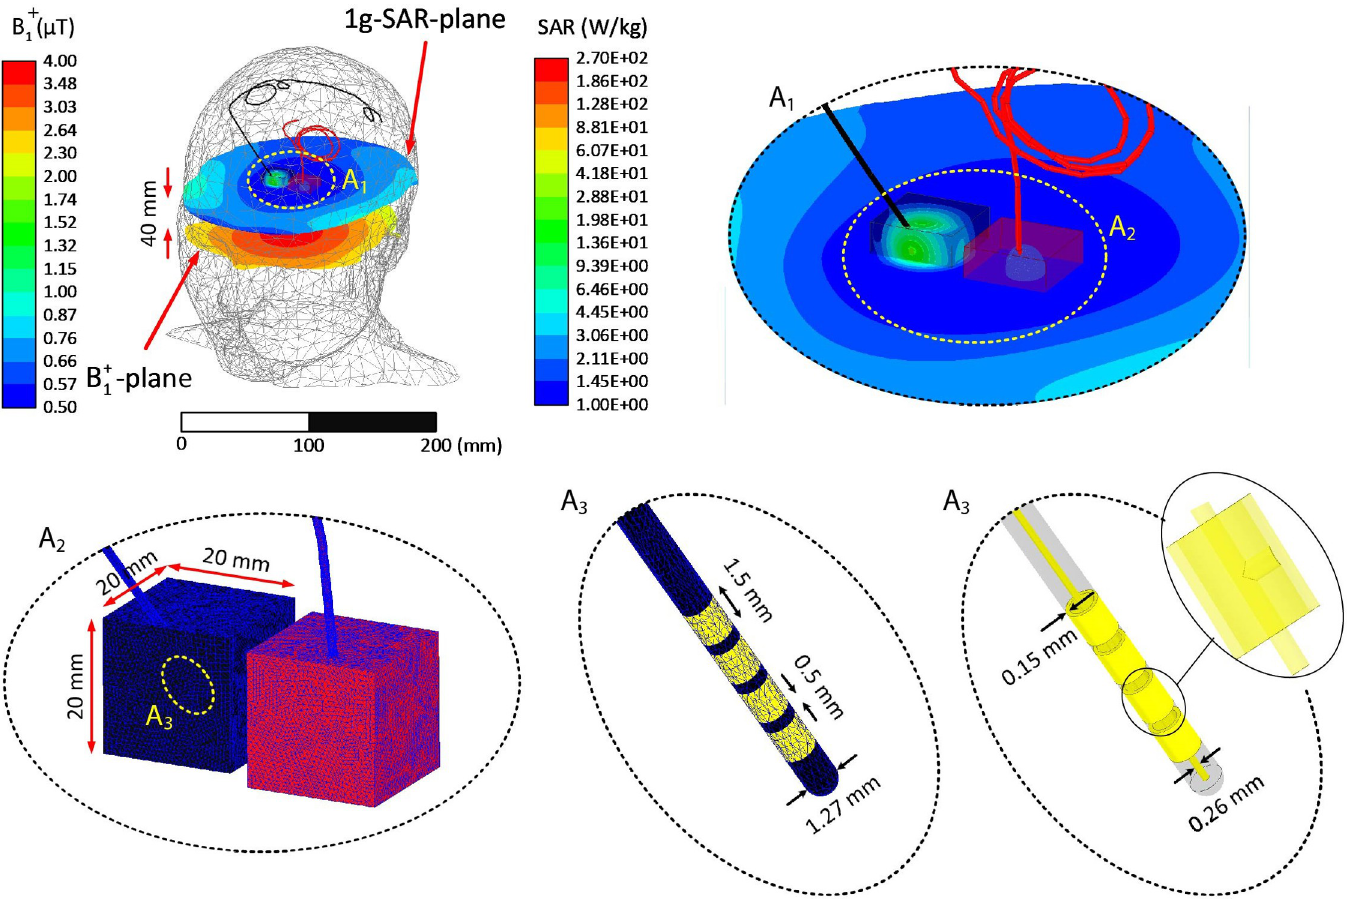
Fig 3. Example of mesh density in the lead, insulation, and SAR boxes of a representative patient (ID12) at 3 T. A1: Closeup view of leads withing the high-resolution mesh regions. A2-A3: Schematic of mesh in the cubic area surrounding the lead tips and on the lead electrodes. A3: View of interconnections between electrodes and the central core. The coil’s input power was adjusted to generate a GHSAR of 3 W/kg. The distribution of 1g-SAR on a plane passing through the lead tips, the distribution of B 1+ on an axial plane passing through the patient’s forehead, and the lead’s contacts’ geometrical details are also